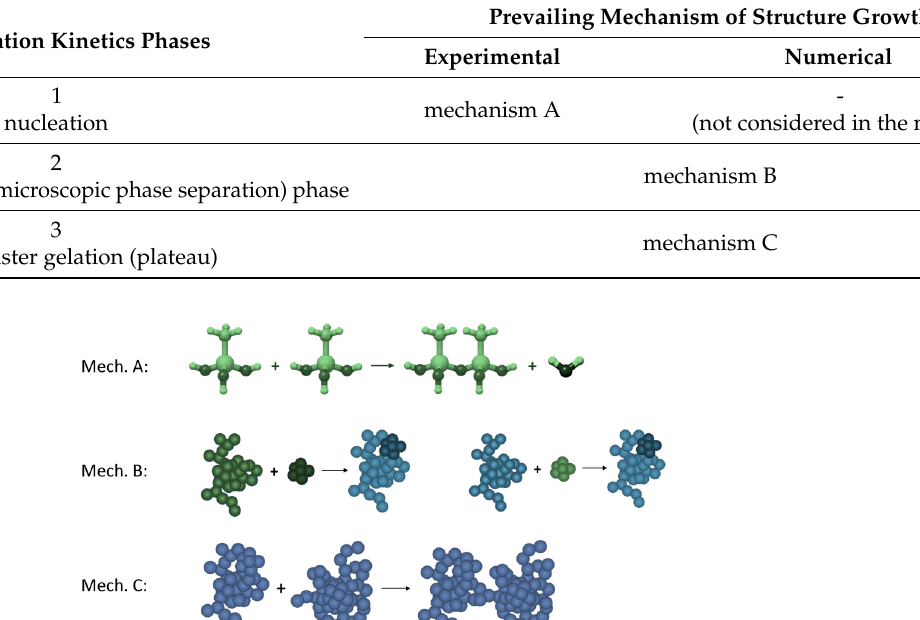
Table 2. Condensation kinetics phases and mechanisms (experimental vs. numerical designation).